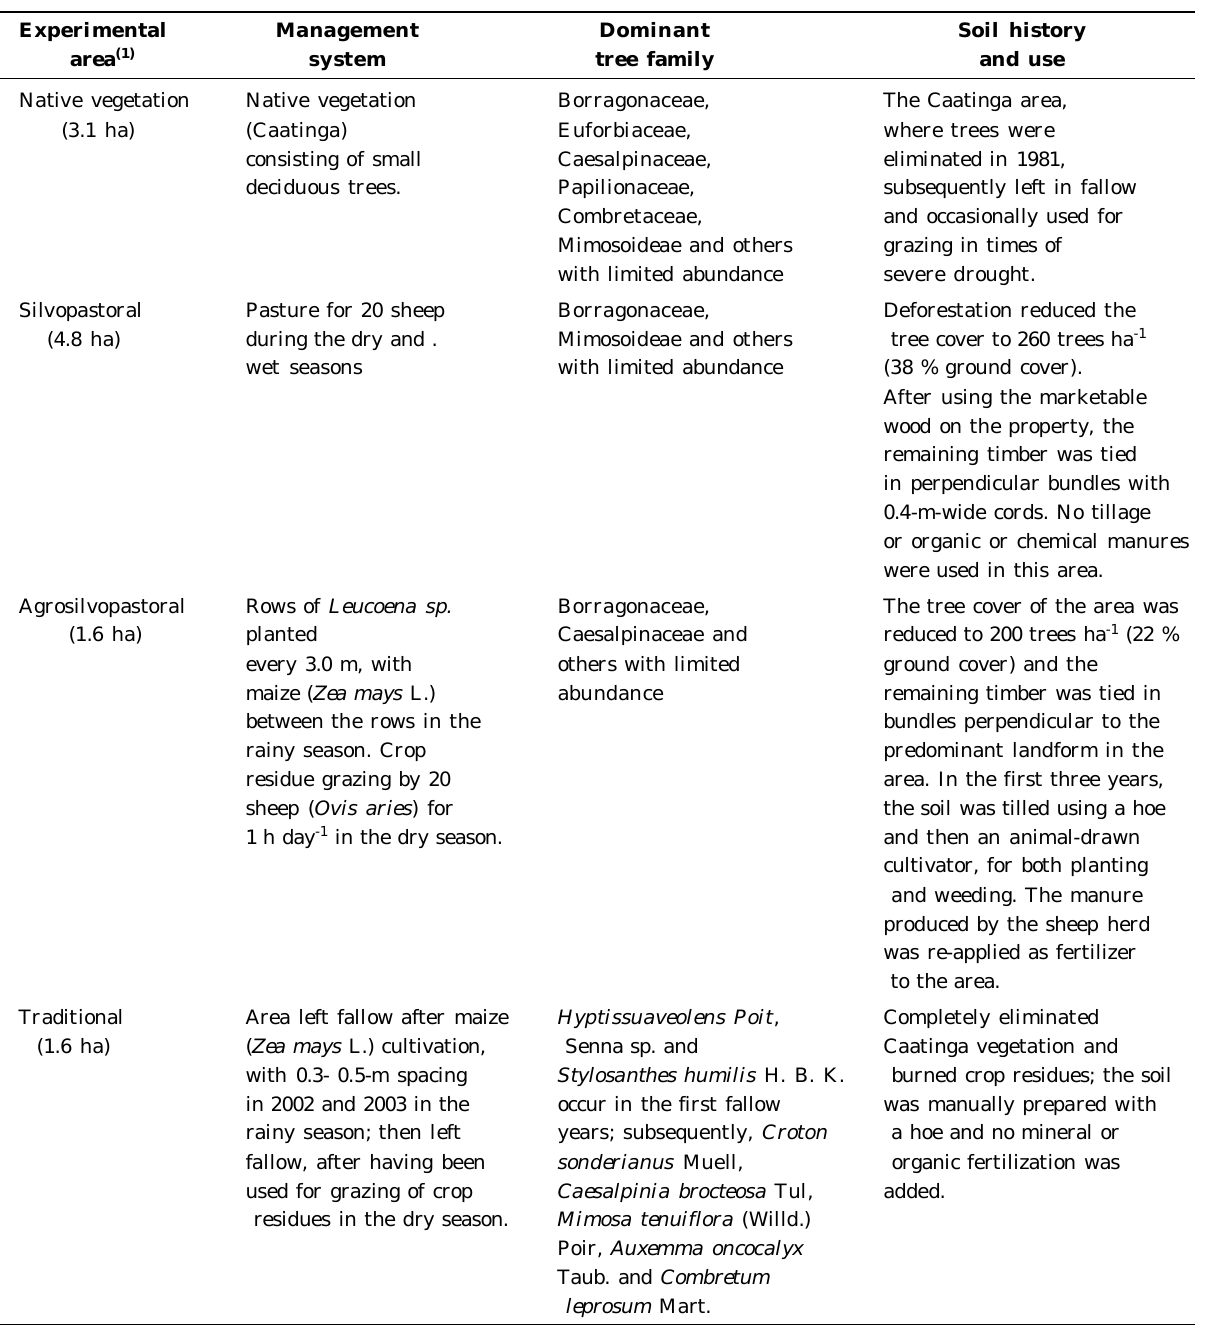
Table 2. Description of the use and management of the experimental areas set in typical Ortic Chromic Luvisol in Sobral, Ceará,